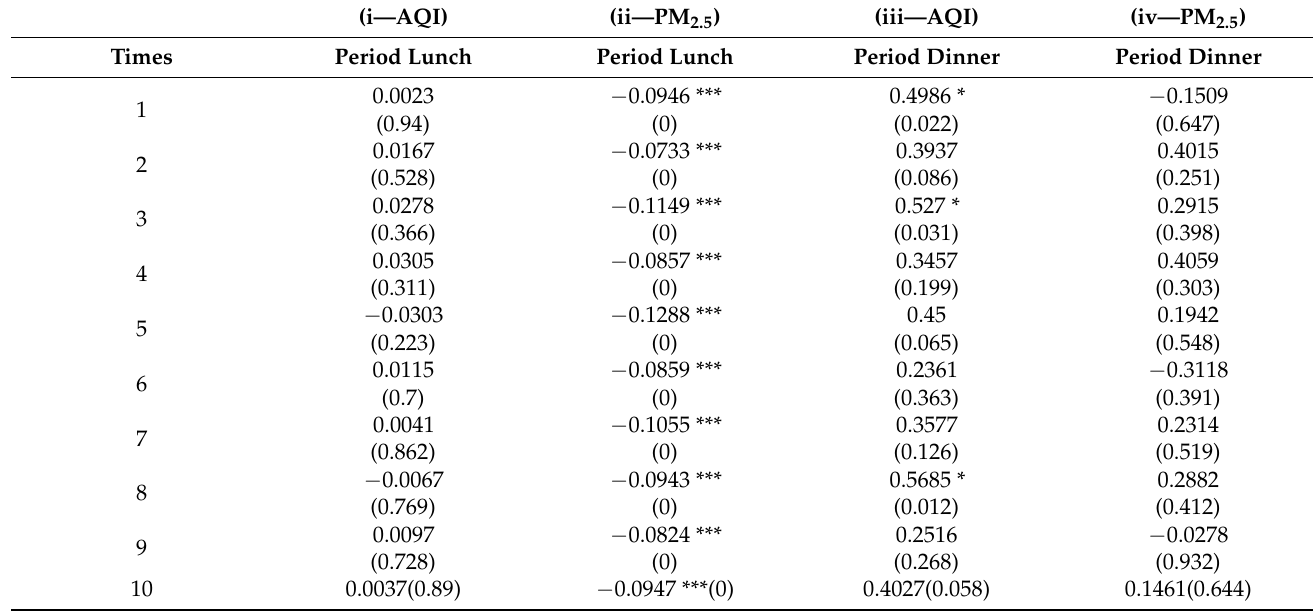
Table A8. Ten times of the effect’s estimation of air pollution on people’s activity on the randomly sampled restaurant POIs.